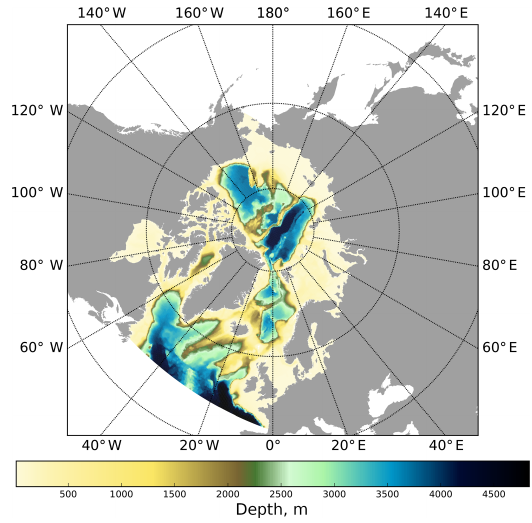
Figure 1. Model domain with